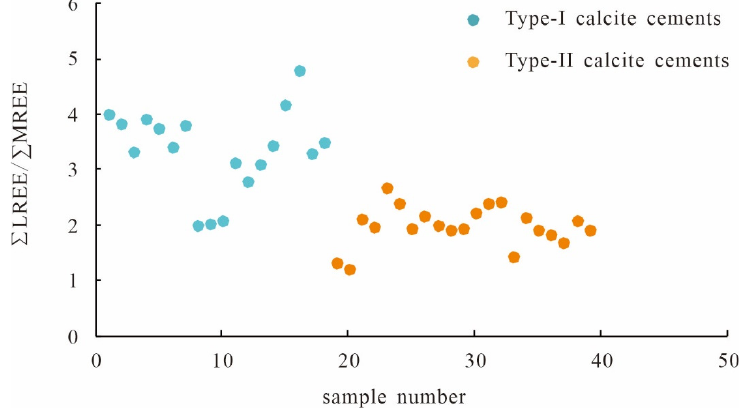
Figure 16. Characteristics of rare earth elements of calcite cements in study